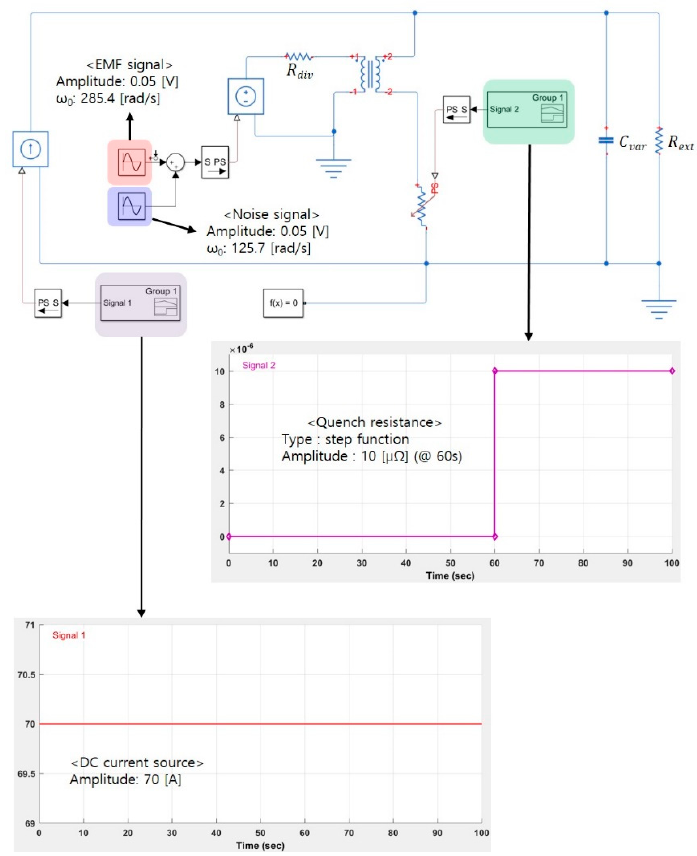
Figure 4. Equivalent circuit of the simulation for verification of the proposed quench detection method.